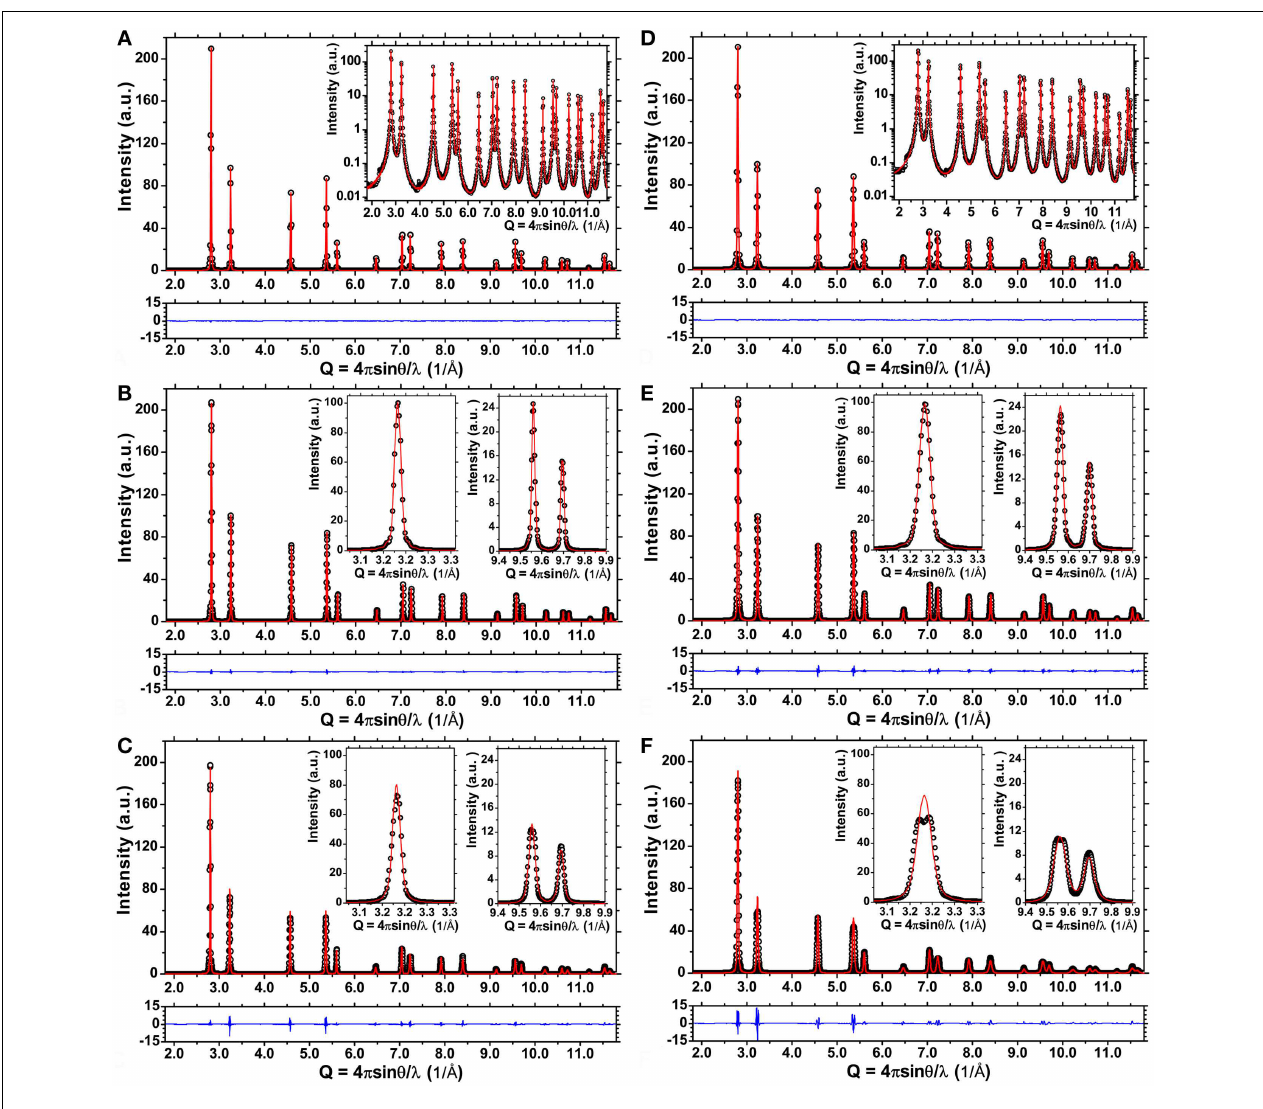
FIGURE 10 | Debye scattering equation powder patterns (dot),WPPM result (line) and difference between the two (line, below) for Pd ideal cylindrical domains, D = 40nm/ H = 28.7nm (Left) and D = 20nm/